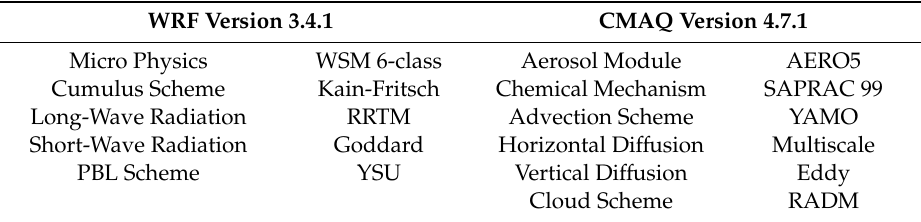
Table 1. The WRF and CMAQ configurations used in the study.